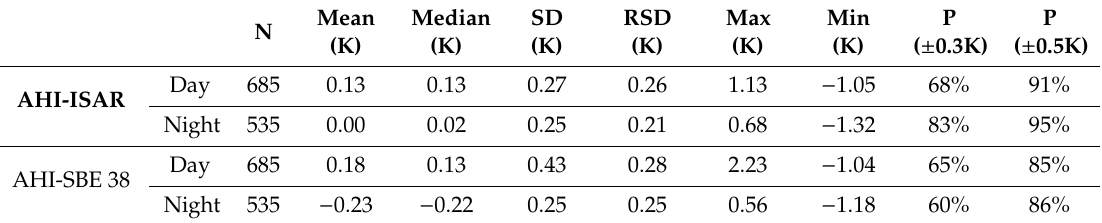
Figure 5a,b show the wind speed dependence of Himawari-8 AHI skin SST matchups with both ISAR skin SST and SBE 38 bulk SST. The red triangles represent matchups in daytime and blue